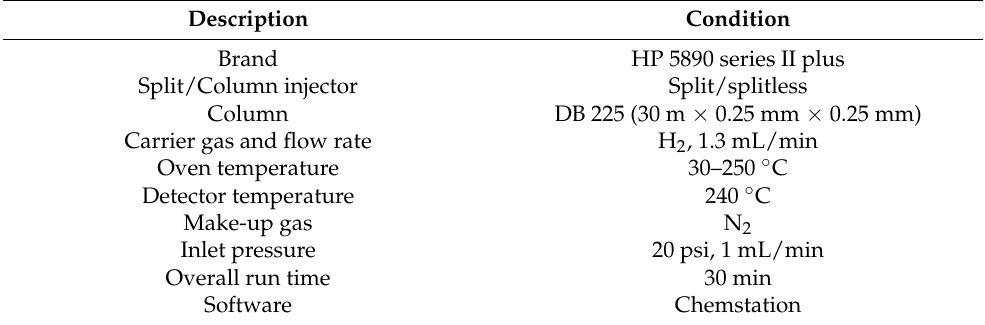
Table A1. Gas chromatography conditions for fatty acid methyl esters (FAMEs)